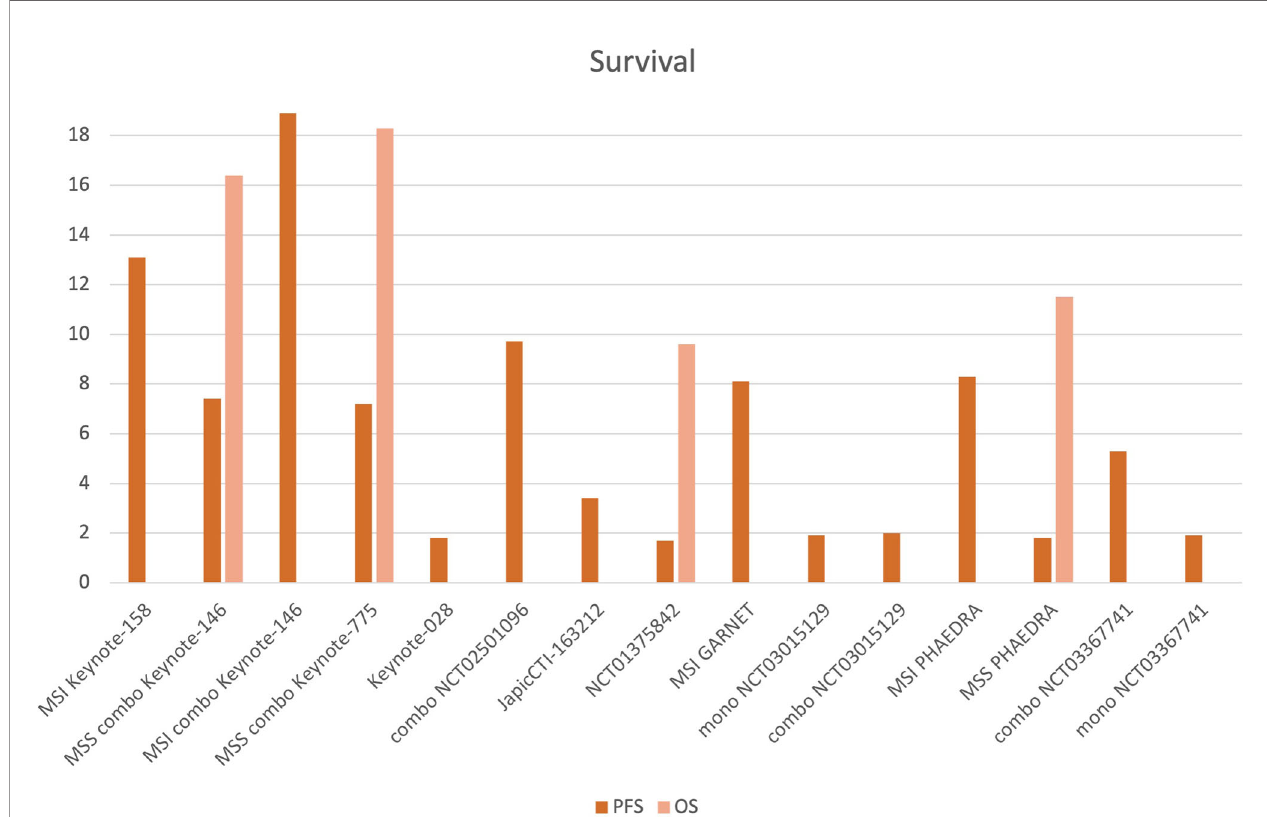
FIGURE 3 | Progression-free survival (PFS) and overall survival (OS) of the included studies. 11 studies reported mPFS, which ranged from 1.7 to 18.9 months. Among MSI patients treated with ICI monotherapy, mPFS was 8.1 months (5.6 – 13.1 mos). With combination ICIs-TKI, mPFS ranged from 7.2 to 18.9 mos (among the 11 MSI patients of Keynote-146), ranging from 6.6 to 7.4 months for MSS patients. mOS was available for 5 studies, ranging from 9.6 to 18.3 mos (MSI, MSS groups and combination —” combo ” studies are